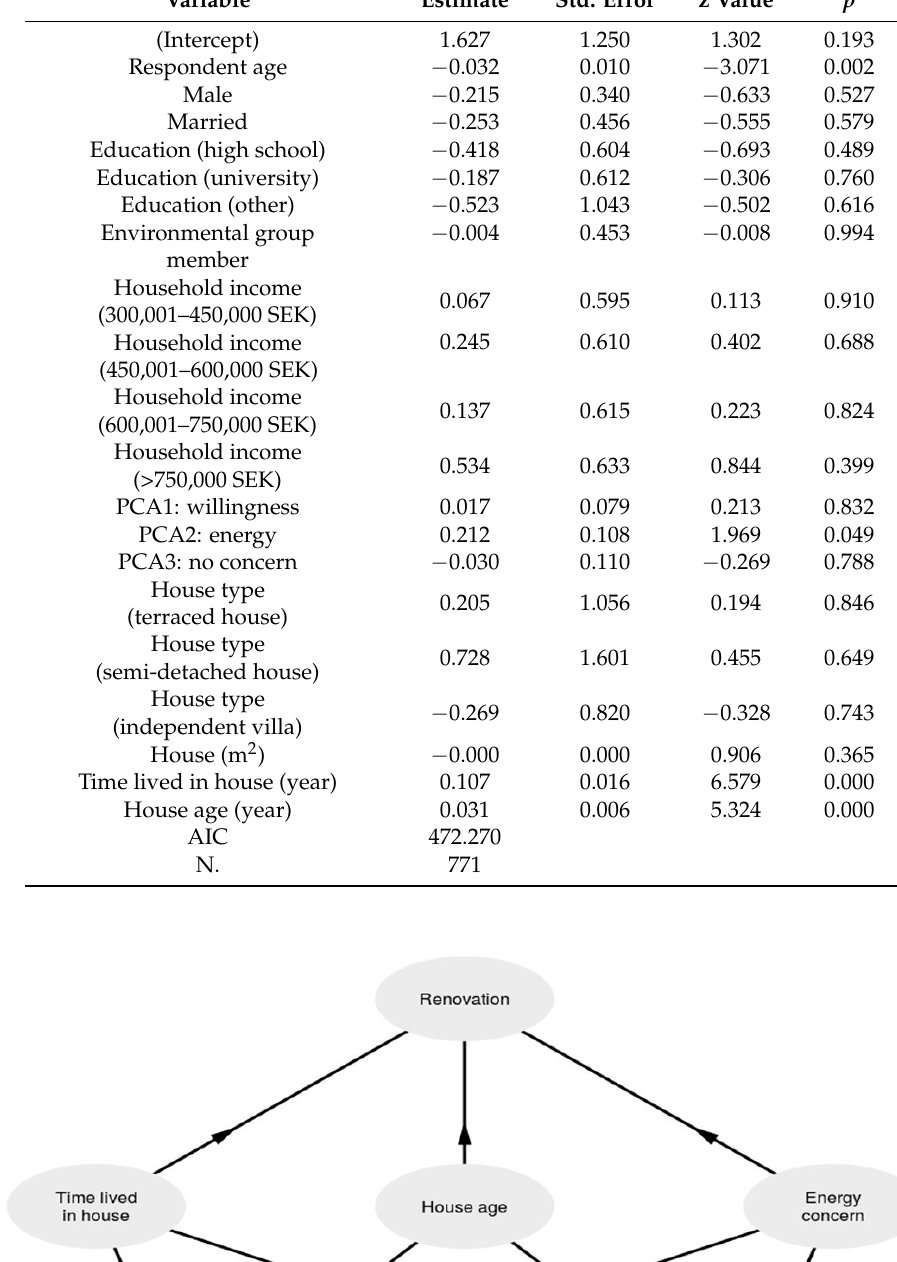
Table 2. Logit model on past renovations. Reference categories are female unmarried, income lower than 300,000 SEK, elementary education and row houses for the house type.